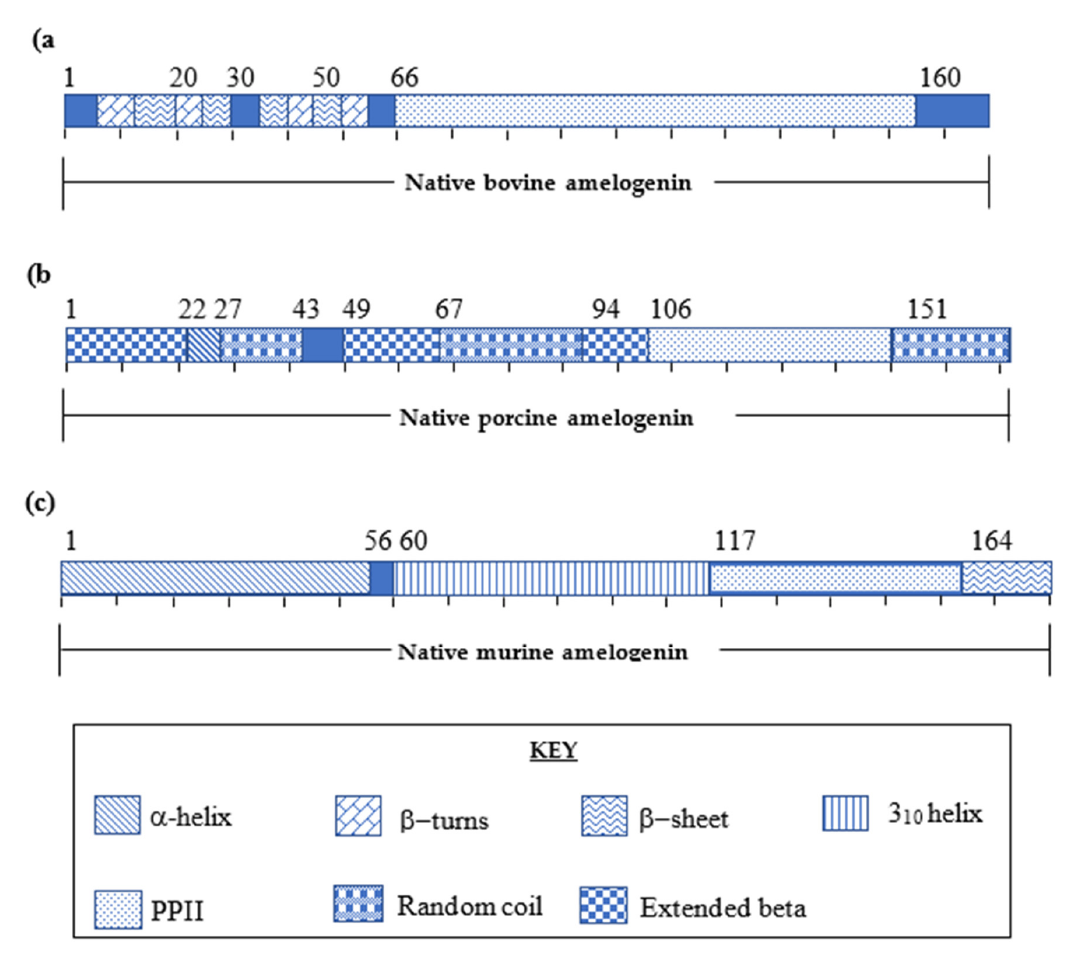
Figure 3. ( a ) Secondary structure of native bovine amelogenin determined by CD, FT-IR and 2D-NMR. ( b ) Secondary structure of native porcine amelogenin determined by VT-CD. ( c ) Secondary structure of native murine amelogenin determined by 3D-NMR.